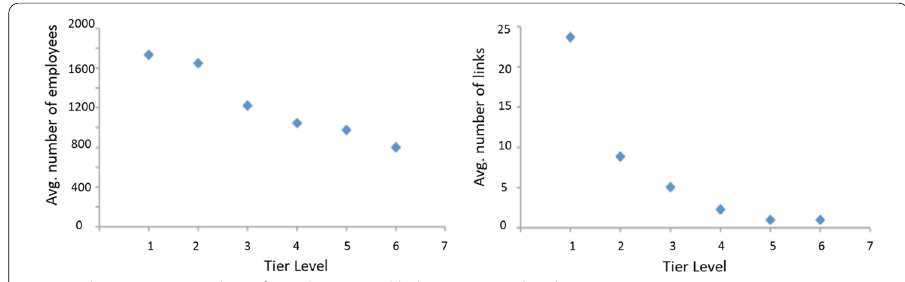
Fig. 4 The average number of employees and links versus tier